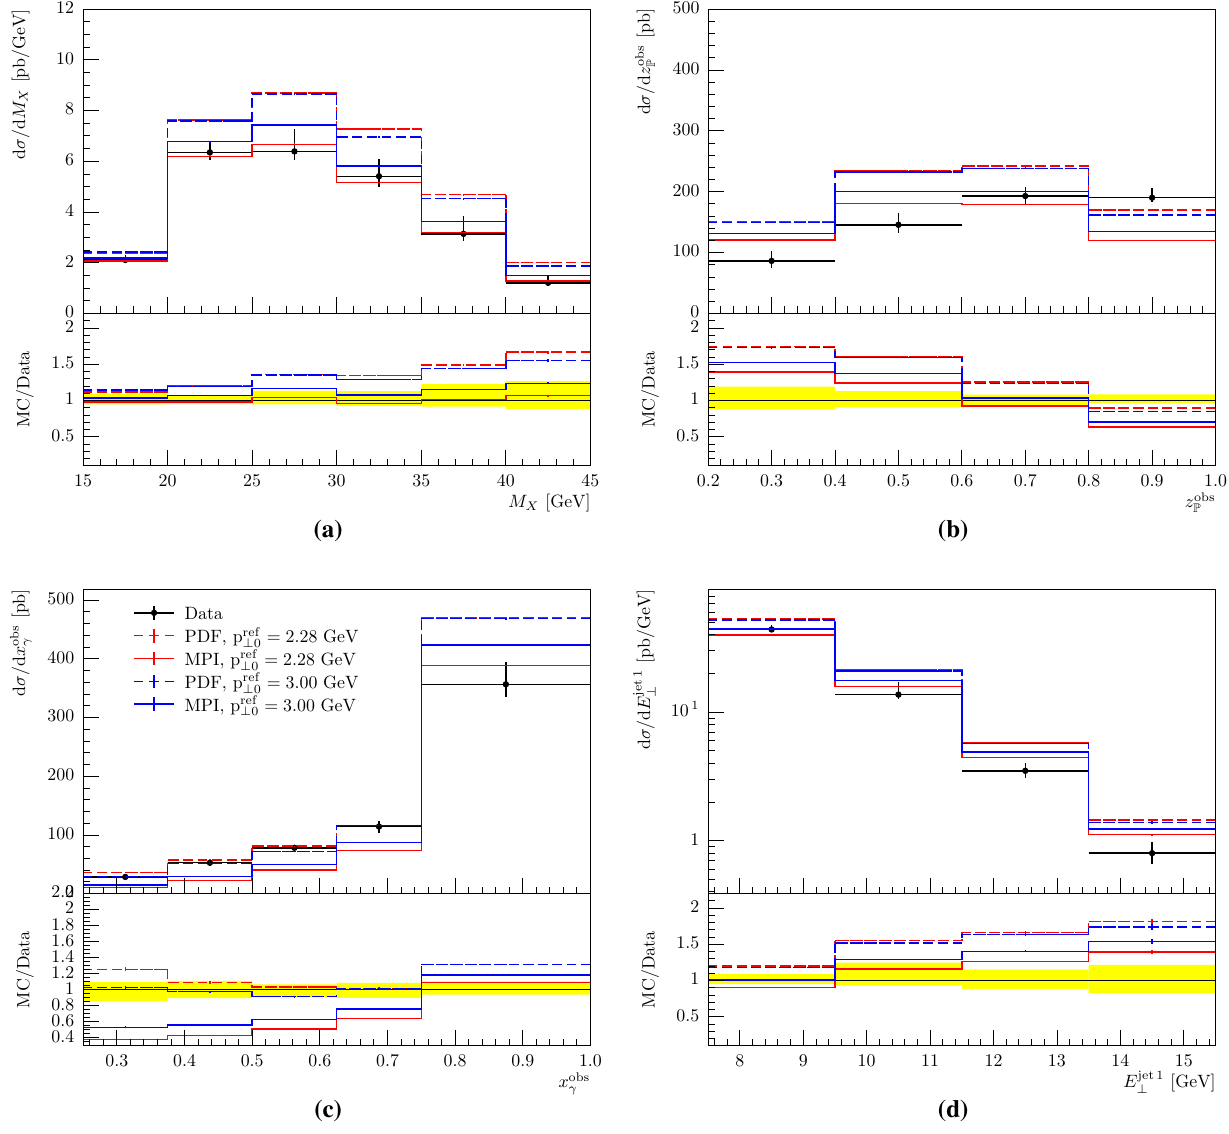
= 2 . 28 GeV (red : The pp-tune, p ref ⊥ 0 0 obs obs γ ( c ) and E jet1 X ( a ), z ⊥ ( d P ( b ), x